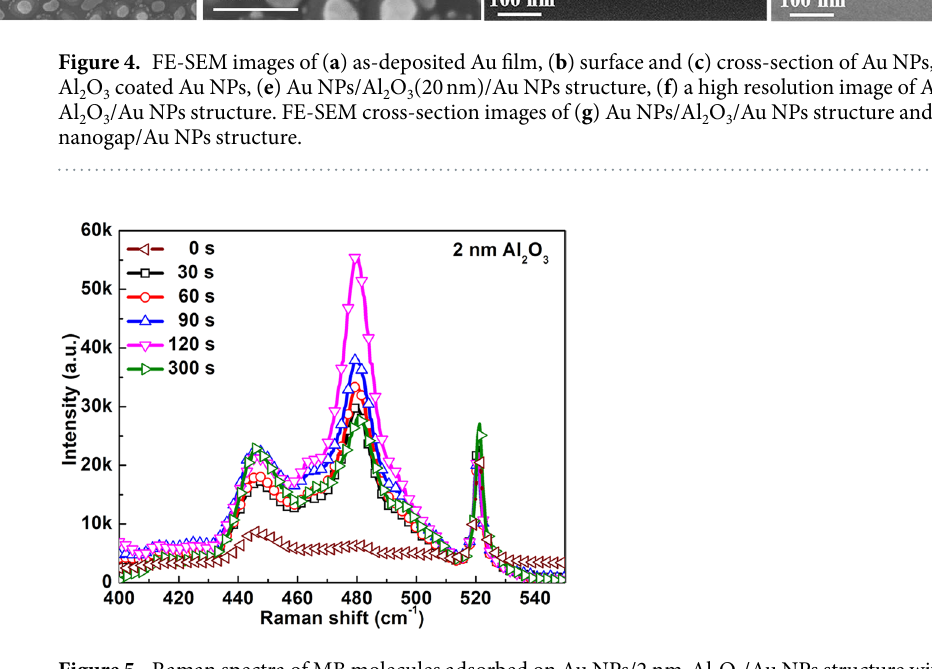
Figure 5. Raman spectra of MB molecules adsorbed on Au NPs/2 nm-Al 2 O 3 /Au NPs structure with various KOH etching time from 0 s–300